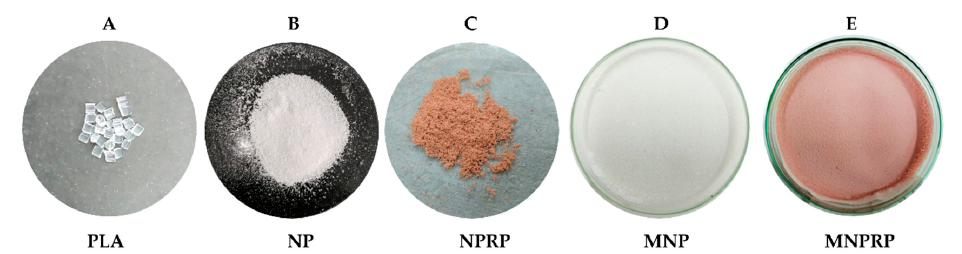
Figure 1. PLA and membranes: ( A ) pure PLA; ( B ) nanoparticles without propolis (NPs); ( C ) nanopar- ticles with propolis (NPRP); ( D ) membrane impregnated with nanoparticles without propolis (MNP); ( E ) membrane impregnated with nanoparticles loaded with propolis (MNPRP).